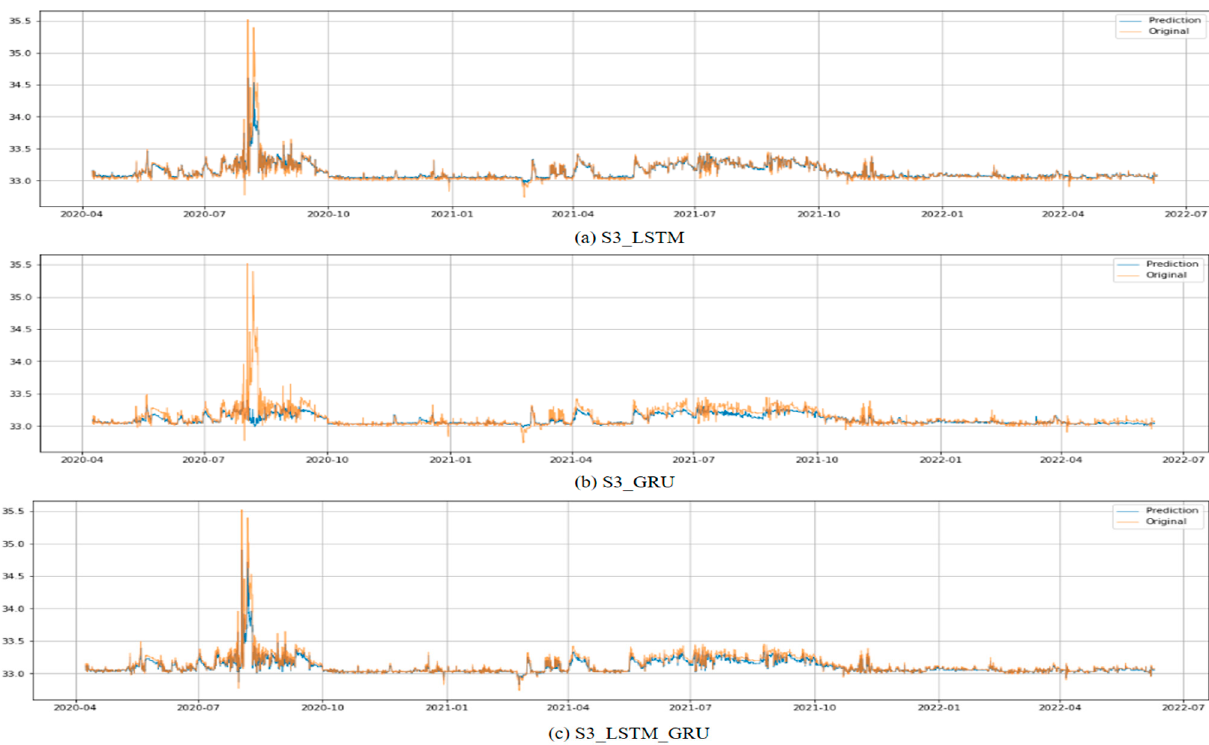
Figure 16. Comparison graph of observed and predicted values for each model in S2 case. ( a ) Multi-LSTM; ( b ) multi-GRU; and ( c ) LSTM–GRU.